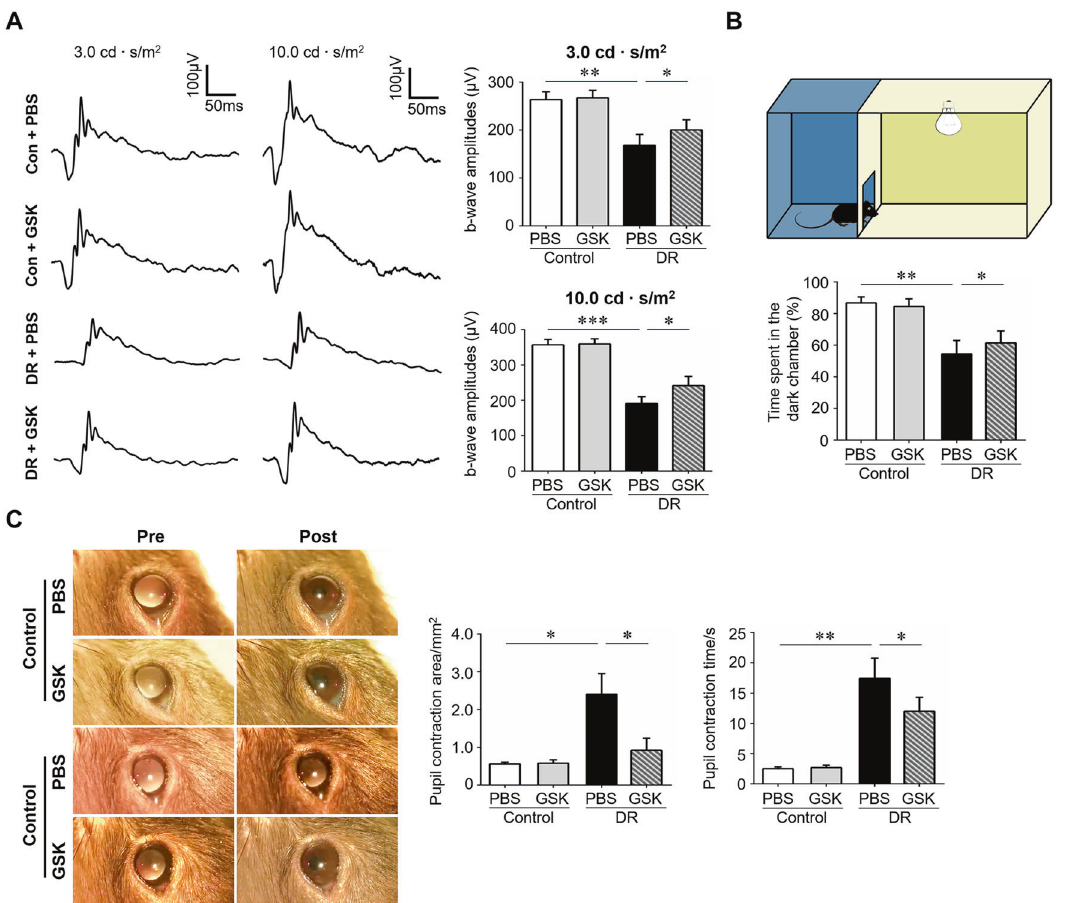
week and 8th week after STZ induction. The experiments were carried out 12 weeks after diabetes induction. A Electroretinogram (ERG) was performed using two fl ash intensities, 3.0 cd·s/m 2 and 10.0 cd·s/m 2 . The amplitudes of b-wave were measured from the average of three responses by a set of three fl ashes of stimulation. n = 10 eyes in each group. B The open fi eld test was carried out to test the light sensitivity and visual functions of the mice. The device consisted of a cage (45 × 30 × 30 cm) divided into a white open fi eld and a dark zone with a door (5 × 5 cm) between them. The time spent in the dark chamber was recorded. n = 12 mice in each group. C Pupillary light re fl ex measured by pupil constriction was conducted to evaluate RGC function. n = 10 eyes in each group. GSK, the speci fi c RIP3 inhibitor GSK872. Data were presented as mean ± S.D. * P < 0.05, ** P < 0.01, *** P <